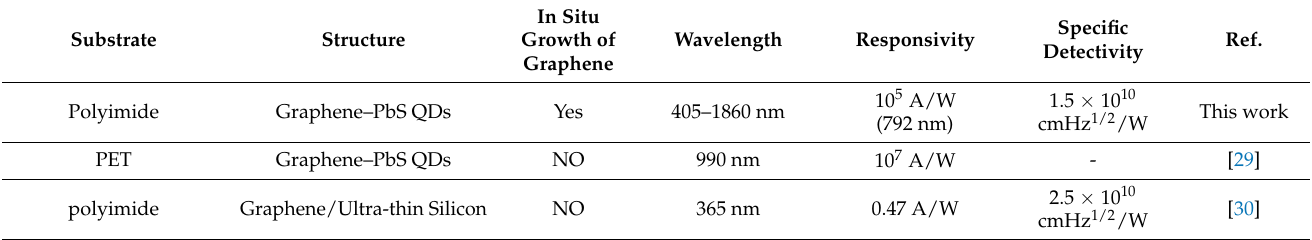
Figure 4. ( a ) The I–V curves of the photodetector with and without bending. ( b ) Dynamic photocurrent output characteristics of the photodetector with and without bending. ( c ) Photocurrent response of the device before (black curve) and after (red curve) a bending test for 100 times. ( d ) The photocurrent change of the device placed in the air within 300 days. ( e ) Responsivity of the device under different wavelengths (405 nm, 632 nm, 792 nm, 1064 nm, 1310 nm, 1550 nm, and 1860 nm). The laser power we used is around 0.4 µW.